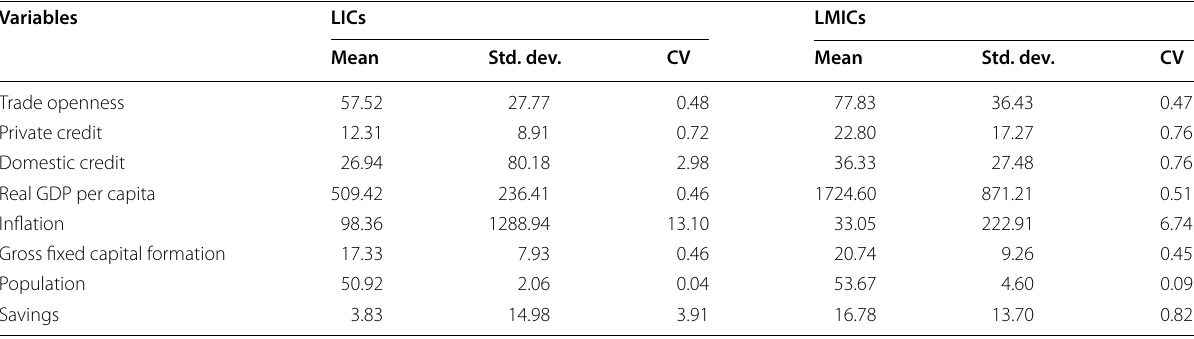
Std. dev. and CV, respectively, denote standard deviation and coefficient to variation. LICs and LMICs represent low-income countries and lower–middle-income countries, respectively